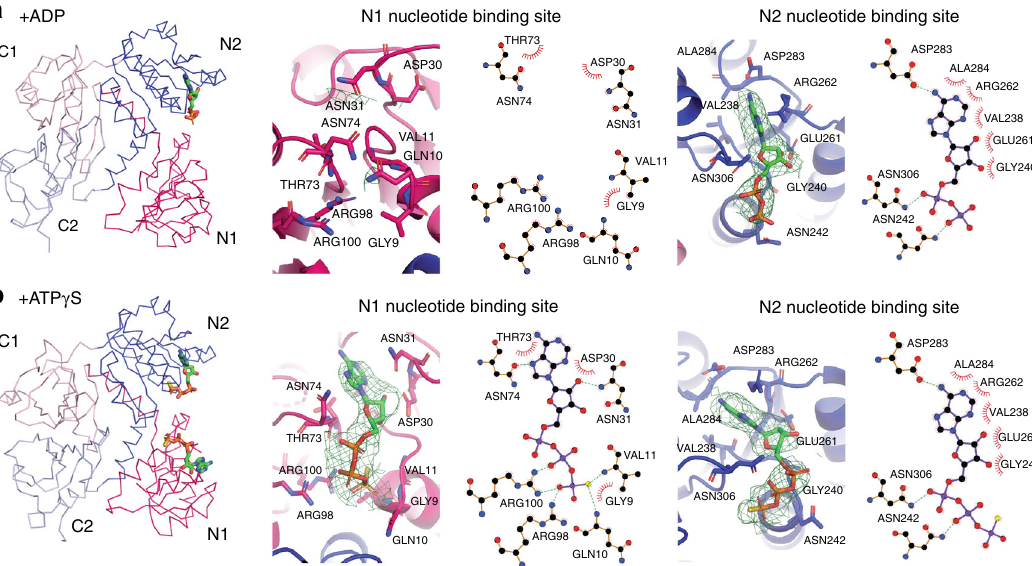
Fig. 3 Interactions between TrkA and different nucleotides. Ribbon representations of TrkA bound with ADP ( a , left panel) or ATP γ S ( b , left panel), and the magni fi ed views of the N1 (middle panels) and N2 (right panels) nucleotide binding sites. The omit map for nucleotides are shown in green meshes at 3 σ . The nucleotide-protein interaction diagrams are drawn using LigPlot + 64 .